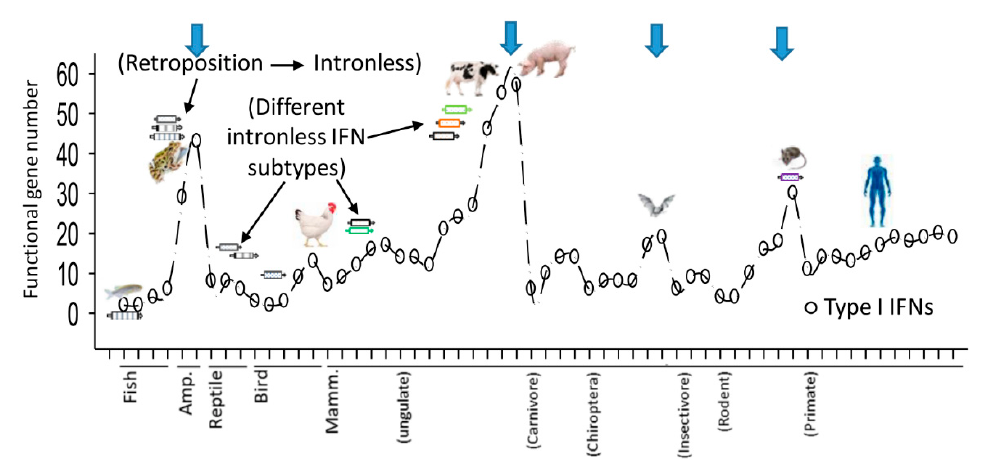
Figure 2. Molecular evolution and diversification of type I IFNs genes (subtypes) in representative vertebrate species [43]. Functional IFN gene numbers are annotated from released genomes of representative species and plotted along the phylogenetic order according to NCBI Taxonomy at http://www.ncbi.nlm.nih.gov/Taxonomy. Several major events including the retroposition leading to emergence of intronless IFNs in amphibians, and expansion of IFNs in amphibians, livestock, bats, and mice are shown (Blue arrows). Recapped from [43].